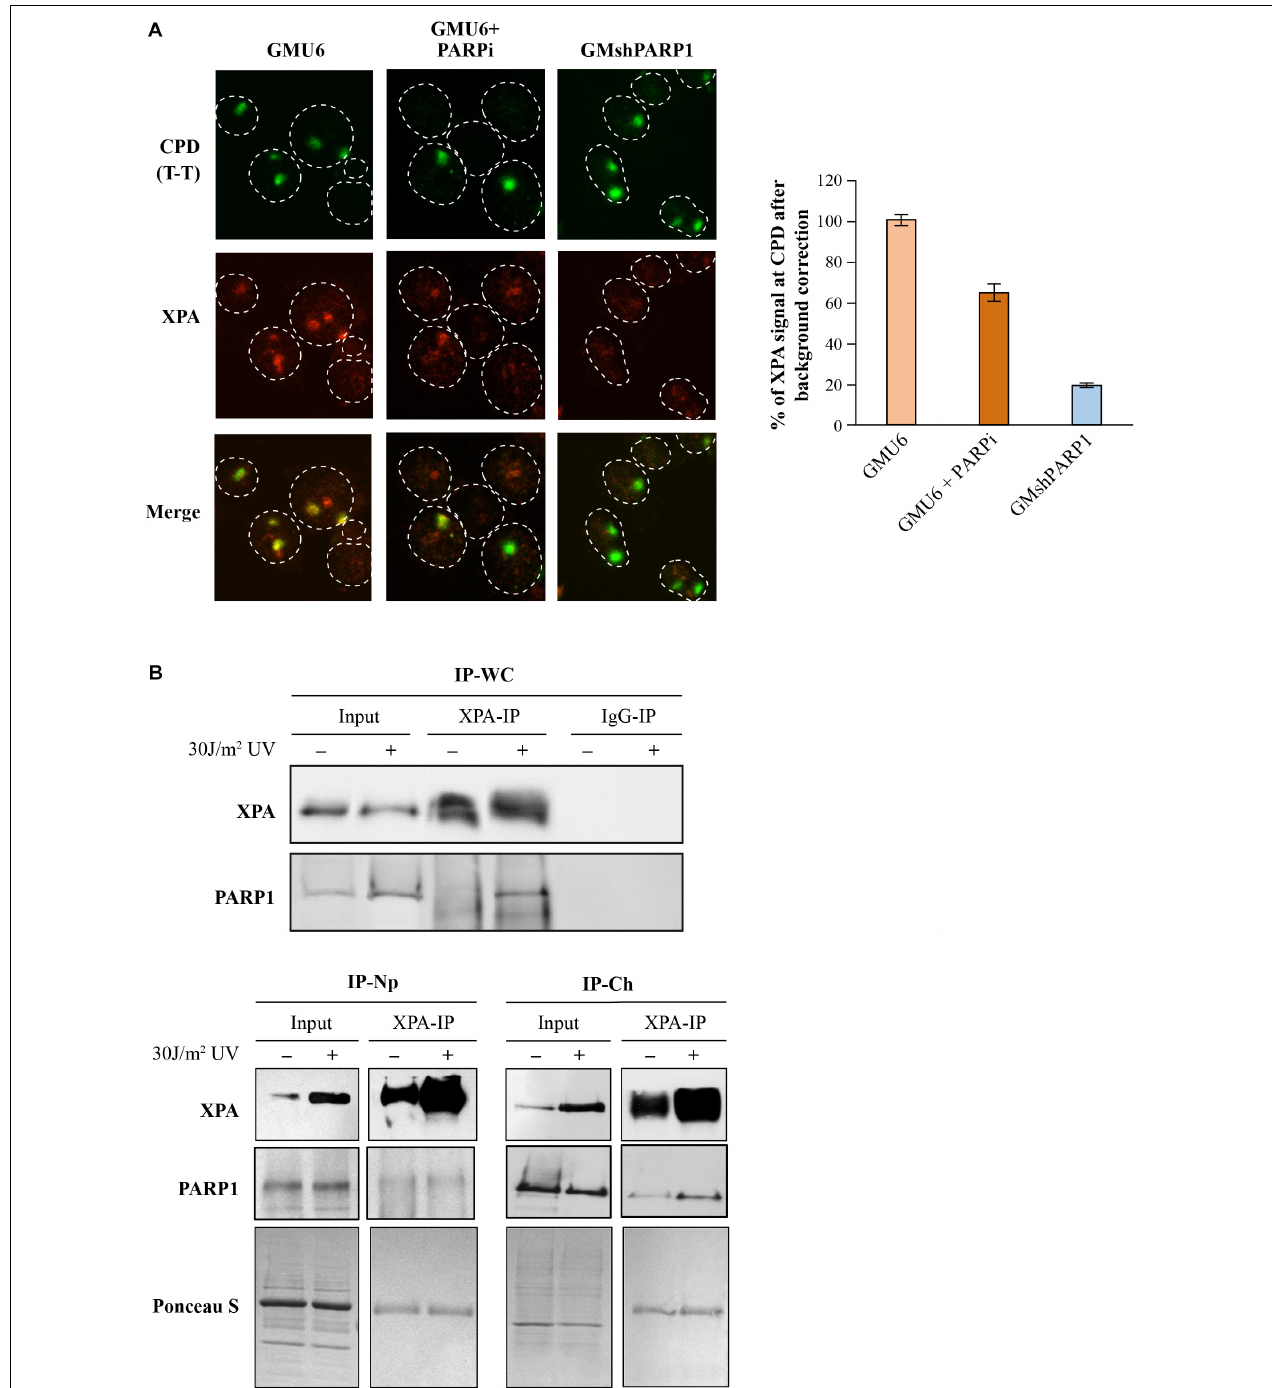
FIGURE 7 | Influence of PARP1 and its catalytic activity on XPA functions. (A) PARP1 deficiency impairs XPA recruitment kinetics at the UVC-damaged chromatin. The PARP1-replete (GMU6), PARP1 depleted (GMshPARP1) and PARP-inhibitor treated PARP1-replete cells (PARPi) were locally irradiated with 100 J/m 2 and processed after 30 min with C+T protocol. The XPA signal at T-T spots was quantified and corrected by subtracting the background nuclear signal for XPA measured in equivalent zones outside the local irradiation subnuclear spots. The data were pooled from at least 100 T-T spots derived from multiple slides from 3 independent experiments. (B) XPA and PARP1 interact with each other at the chromatin after UV irradiation. The GMU6 cells were globally irradiated with 30 J/m 2 and fractionated after 10 min to obtain the Np and Ch protein fractions. The XPA- and IgG-IP (mock IP) were performed for the control and UV-treated fractions, followed by the detection of PARP1 and XPA. Ponceau S staining was used as loading control.